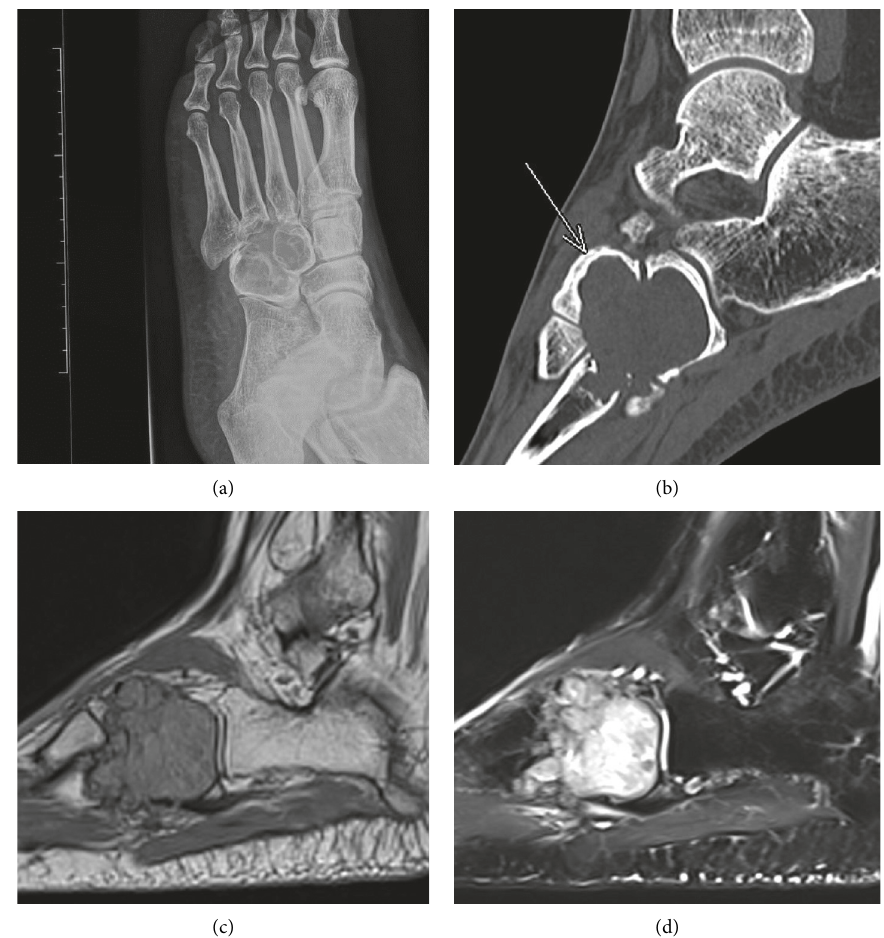
Figure 1: (a) Plain X-ray of left foot demonstrated an expansile lytic lesion in cuboid and lateral cuneiform. (b) CTscan highlighted its well- defined margin and cortical scalloping of lateral cuneiform (arrowed). (c) MRI showed PD-intermediate signal of the lobulated lesion with distal cortical perforation and (d) hyperintense signal on